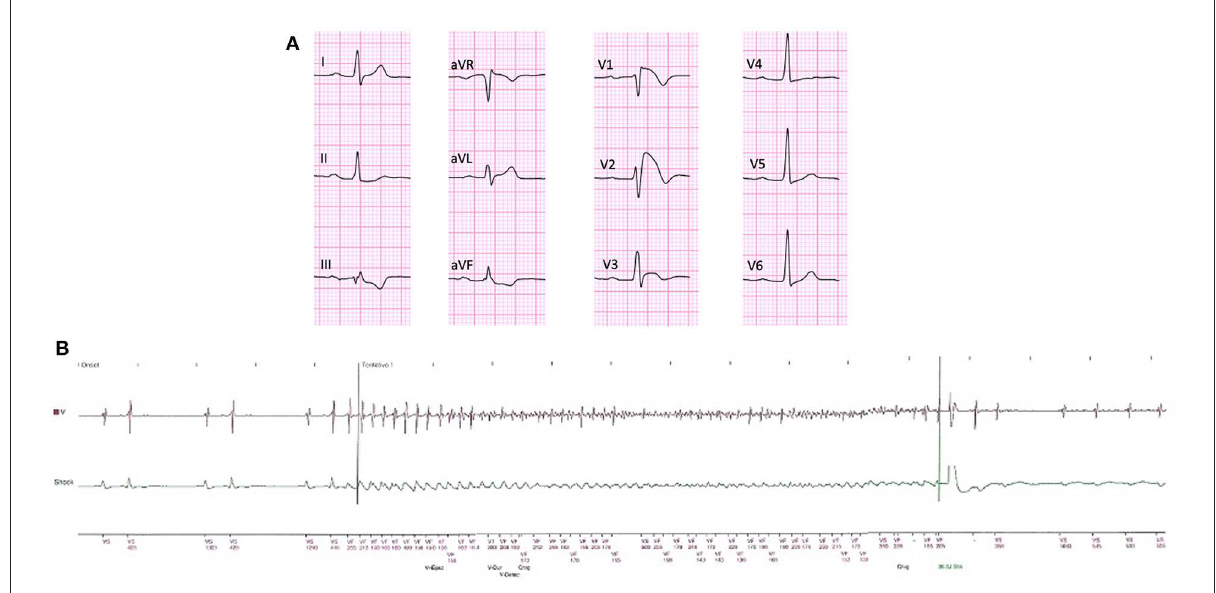
FIGURE1 Baseline ECG of an asymptomatic BrS patient who experienced VF 4 years and 6 months after generator replacement. Note the presence of first-degree AV block and S-wave in lead I as well as spontaneous “coved type” ECG pattern in leads V1 and V2 (A) . Intracardiac electrocardiogram obtained from the transvenous ICD remote monitoring showing the onset of VF, triggered by a premature ventricular contraction and its offset by the ICD shock (B) .